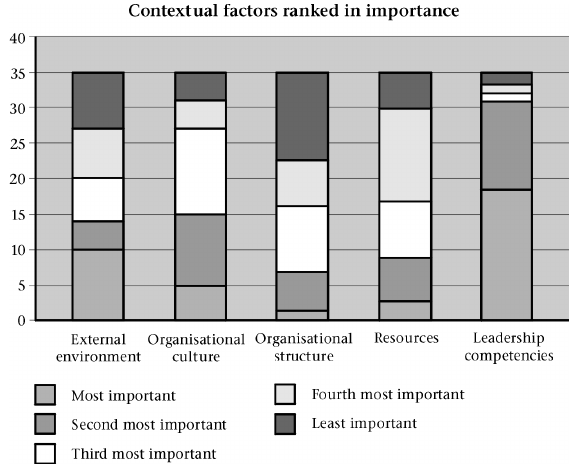
Figure 7: All contextual factors ranked in